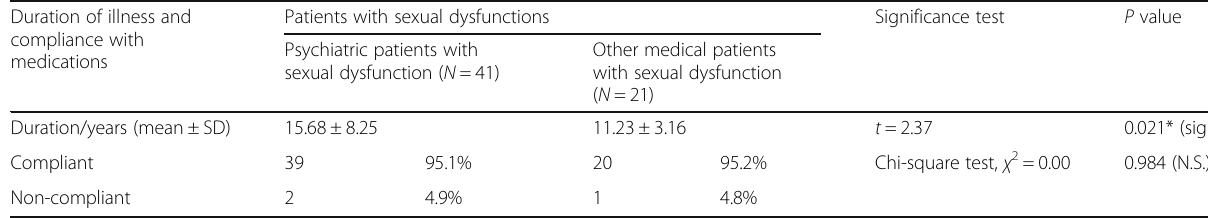
Table 12 Comparison of duration of illness and compliance with medications among psychiatric patients with sexual dysfunctions and other medical patients with sexual dysfunctions Duration of illness and compliance